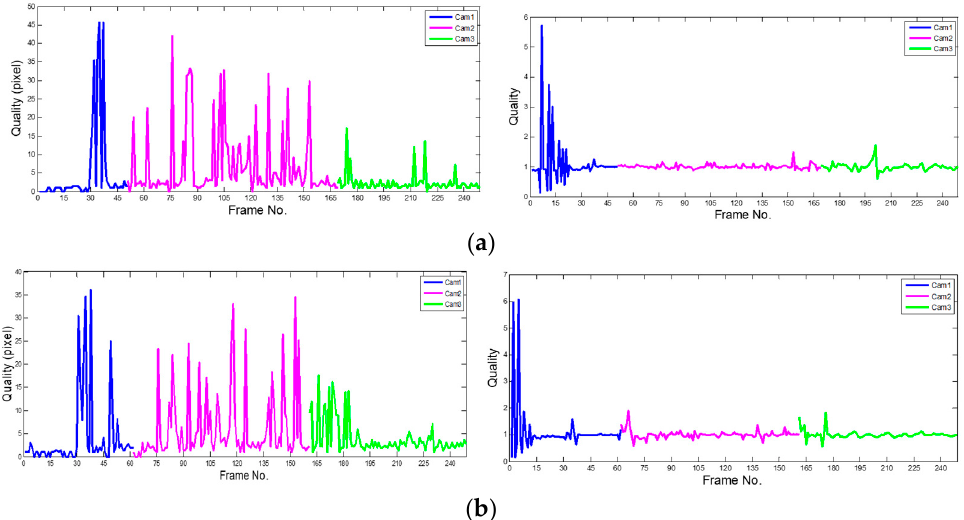
Figure 19. Two persons tracking in overlapping scene.